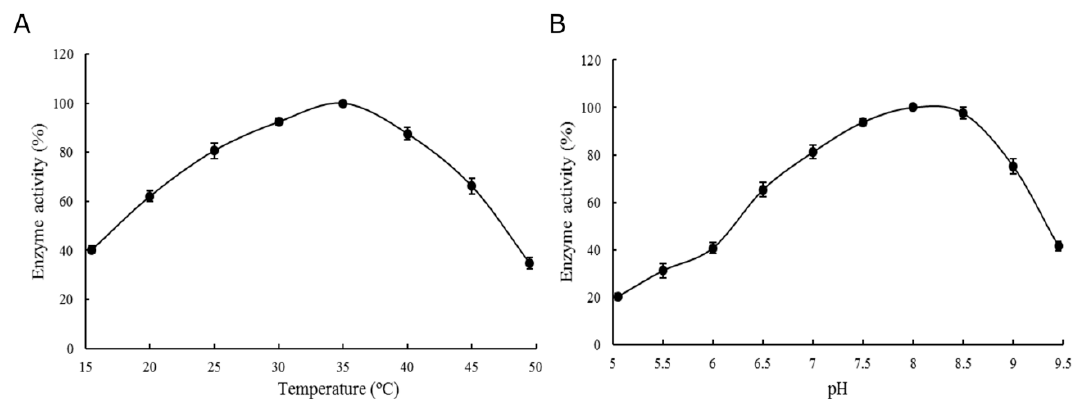
Figure 6. Effects of temperature and pH on EstA activity. ( A ) Temperature; ( B ) pH.